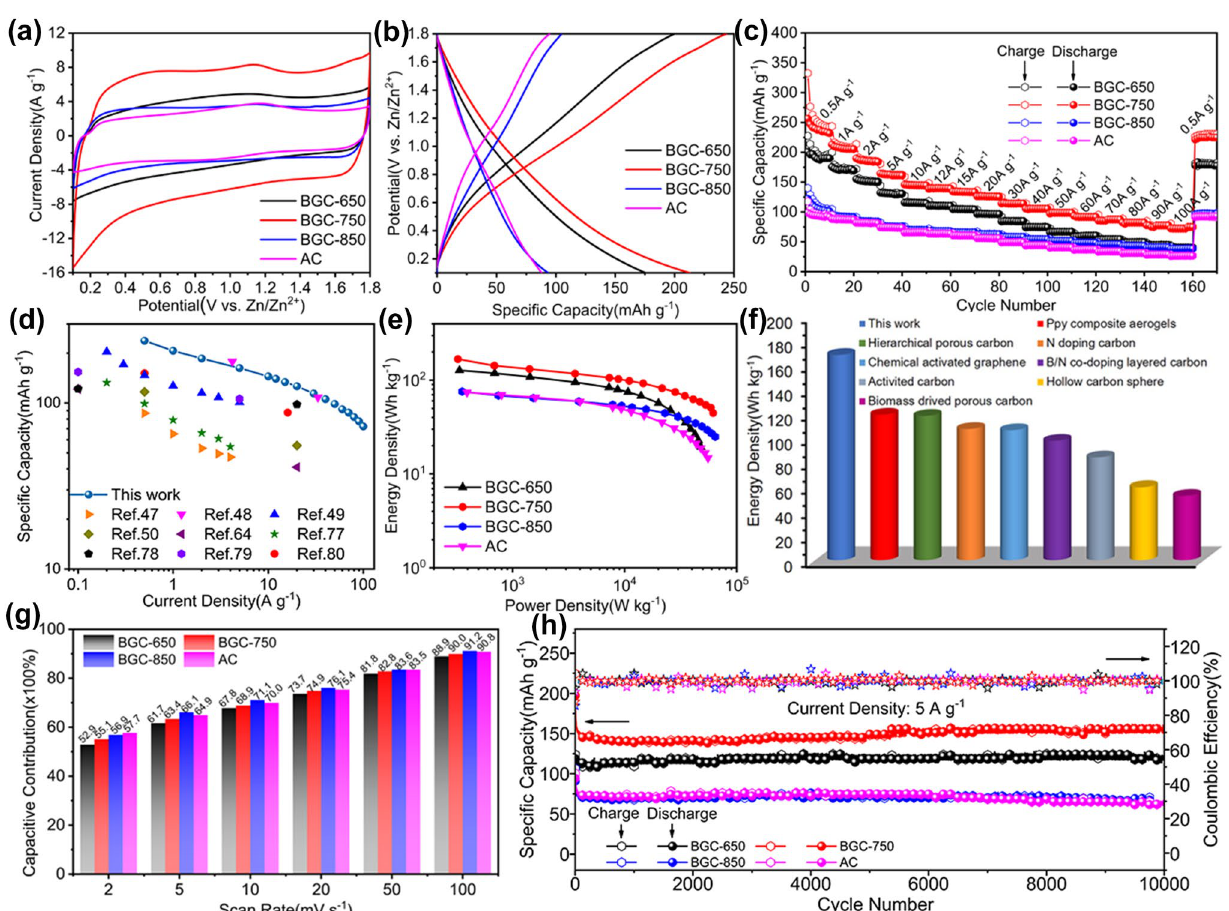
Fig. 2 Electrochemical performance of BGCs and AC cathodes-based zinc ion capacitors. a CV curves at 20 mV s −1 . b Galvanostatic charge– discharge profiles at 1 A g −1 . c Specific capacities at various current densities. d Rate performance comparison of BGC-750-based zinc ion capacitors versus literature reported values. e Ragone plot of BGCs and AC-based zinc ion capacitors. f Maximum energy density of BGCs ver- sus the state-of-the-art carbon cathodes. g Normalized contribution ratio of capacitive capacities at different scan rates. h Cyclabilities of BGCs and AC at 5 A g